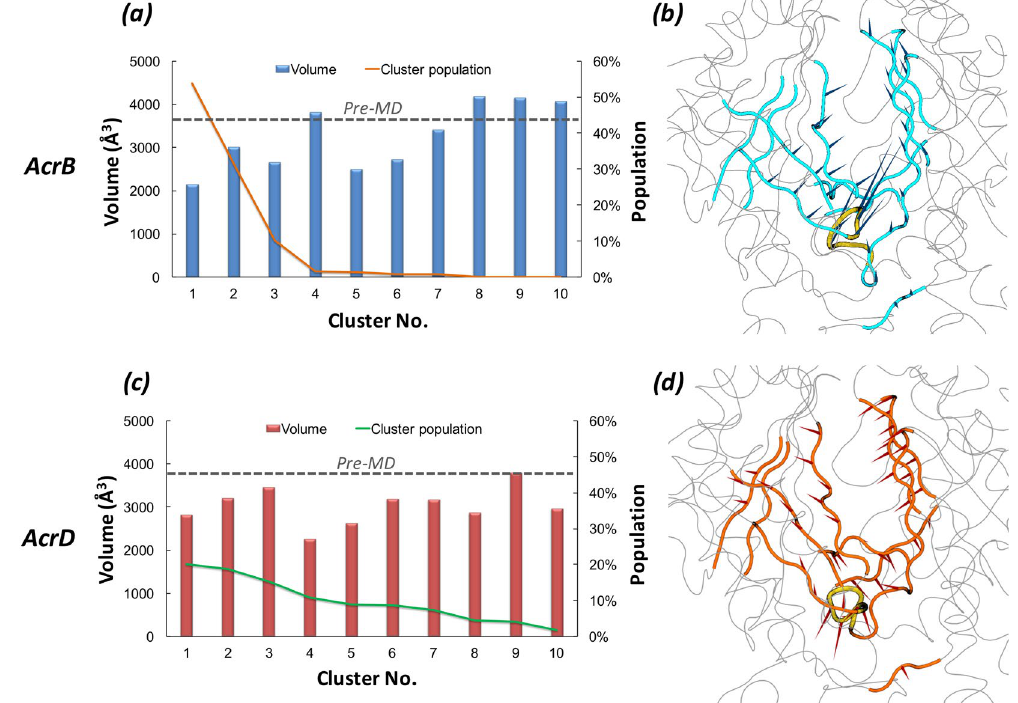
Figure 3. Volume dynamics of AP in the Loose protomer of AcrB and AcrD. (Left Panels) Distribution of the volume of AP within the Loose protomer of AcrB ( a ) and AcrD ( c ), calculated for the 10 top cluster representatives extracted from equilibrium MD trajectories. Histograms refer to the values of the volume, lines to the relative population of the corresponding clusters. The volumes calculated for the pre-MD structures of AcrB and AcrD are shown as dashed line. (Right Panels) Porcupine plots representing collective motions along the first principal-component eigenvector for AP in AcrB ( b ) and AcrD ( d ) simulations shown as arrows ( > 2 Å) attached to C α atoms indicating the magnitude of the corresponding eigenvalues. The loop lining the base of AP (‘bottom-loop’) showing large rearrangement in AcrB but not in AcrD are coloured yellow in both.